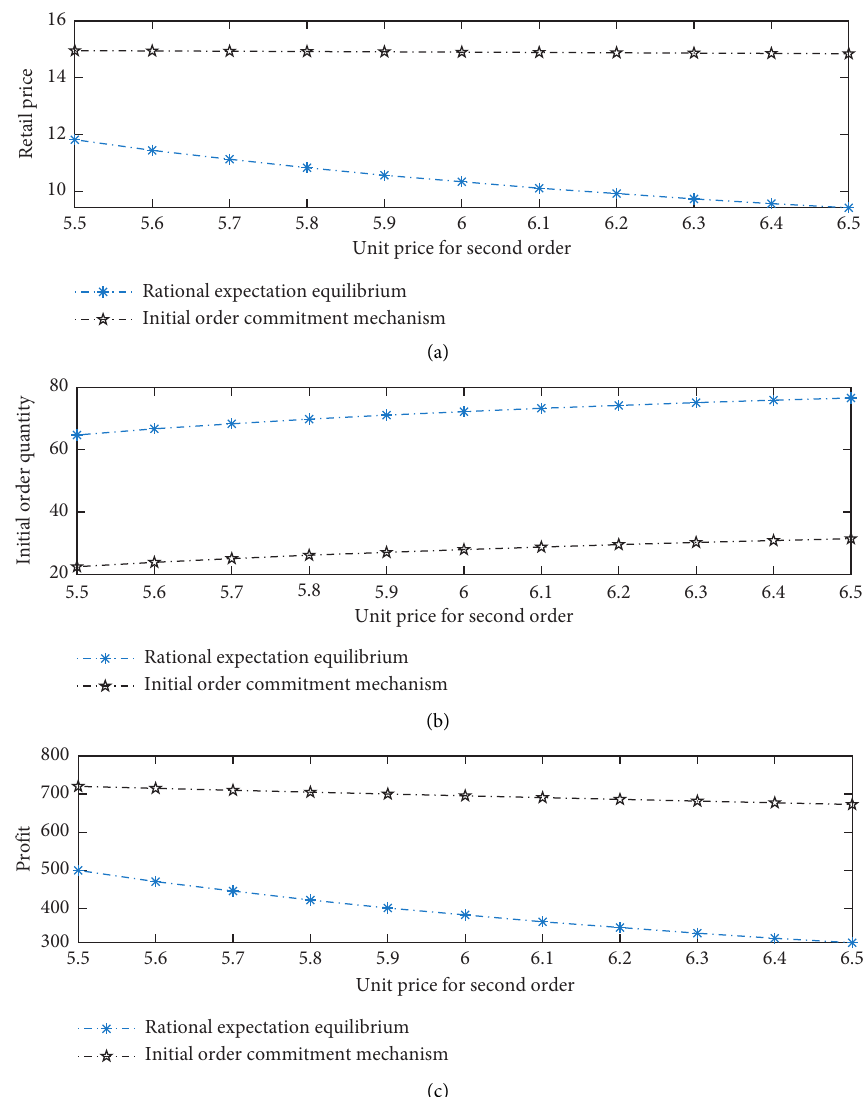
Figure 6: Comparison of rational expectation equilibrium and initial order quantity commitment